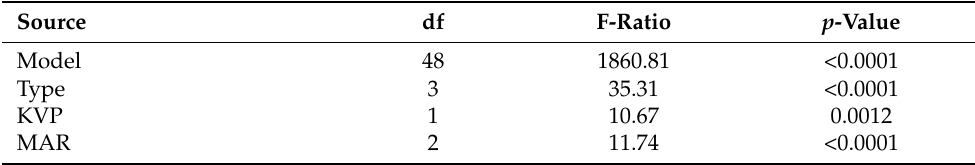
Table 1. Abbreviated analysis of variance table for artifacts ( R 2 =